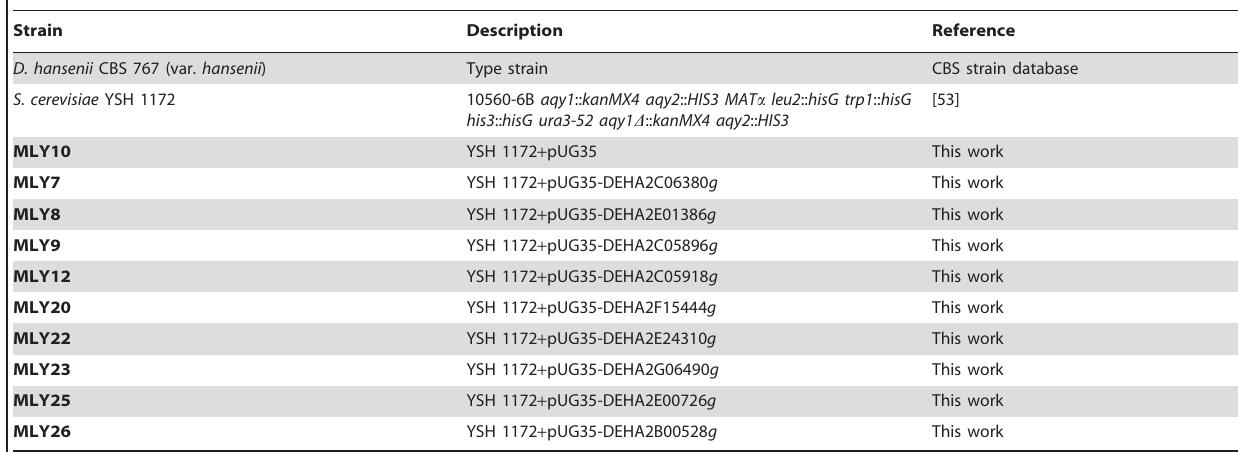
Table 2. Strains used or generated in this